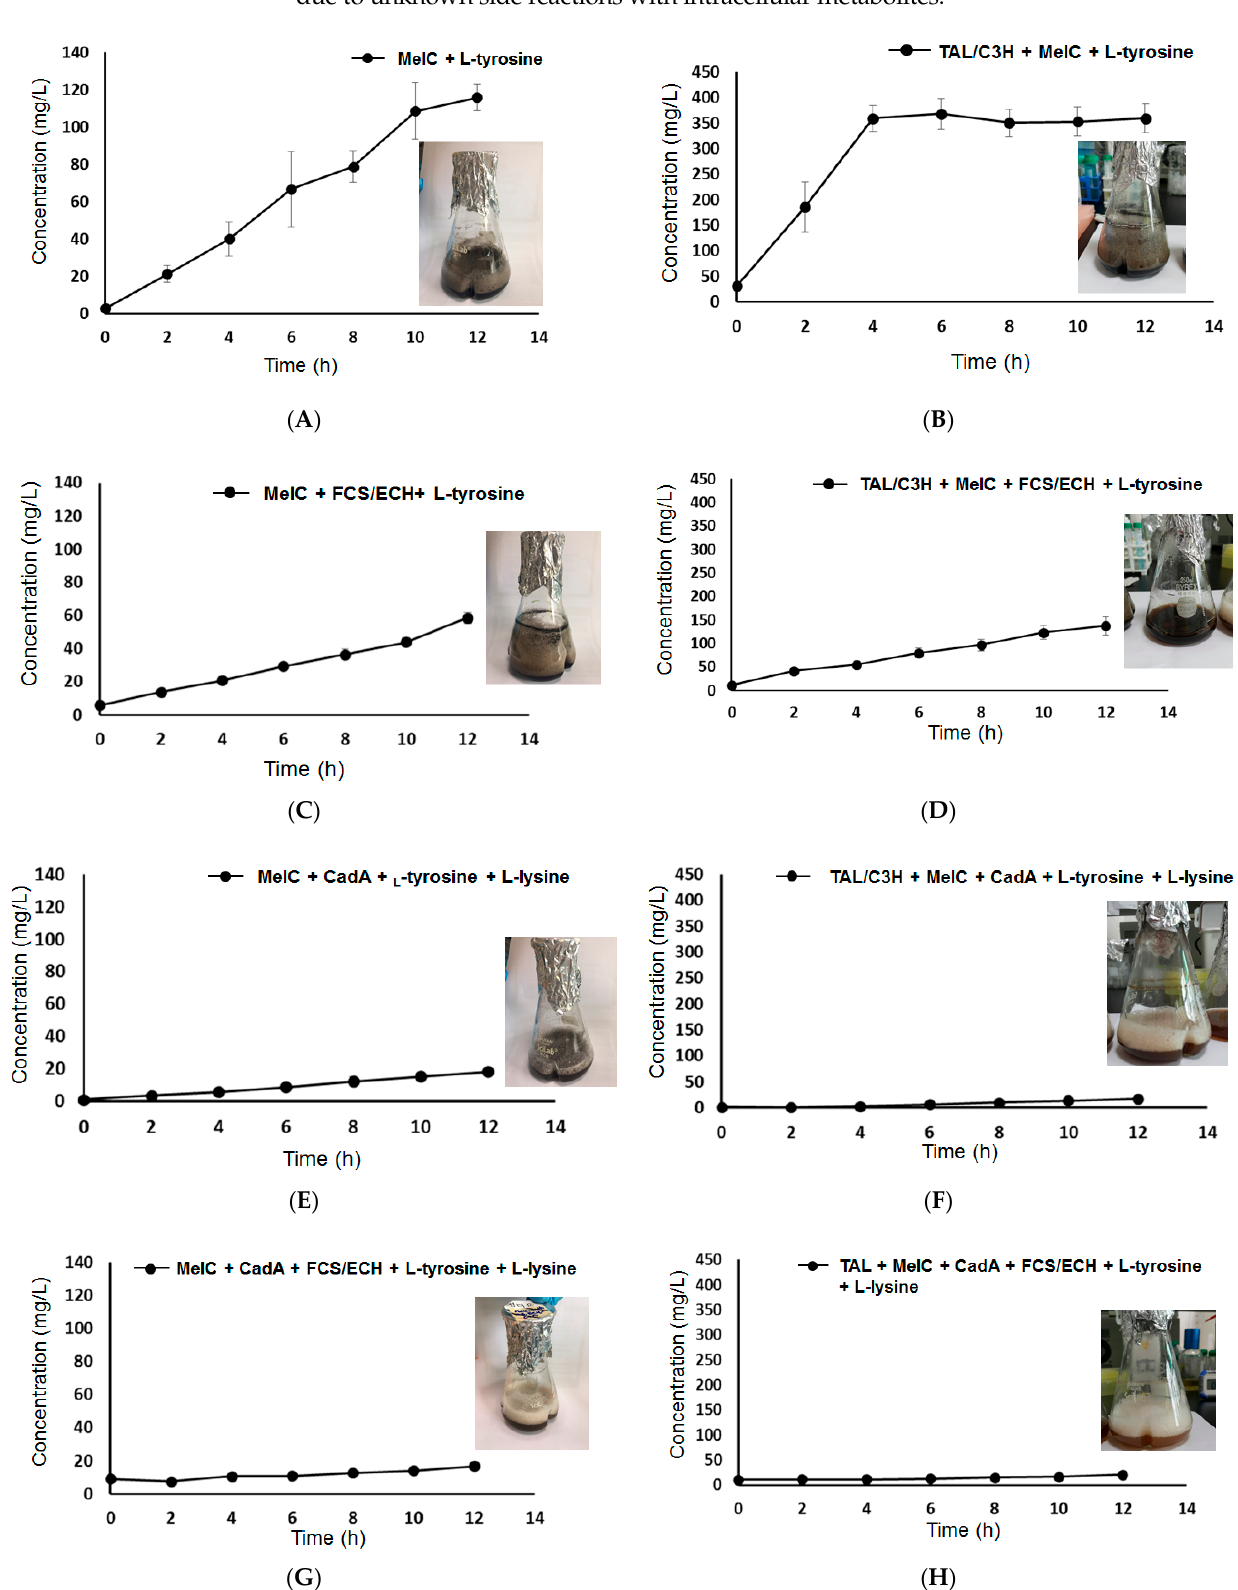
Figure 5. Eumelanin and melanin-diamine complex production profile in various enzyme expression levels. The detailed information of overexpressed enzymes in figure A - H and approximate titers are summarized in Table 2.